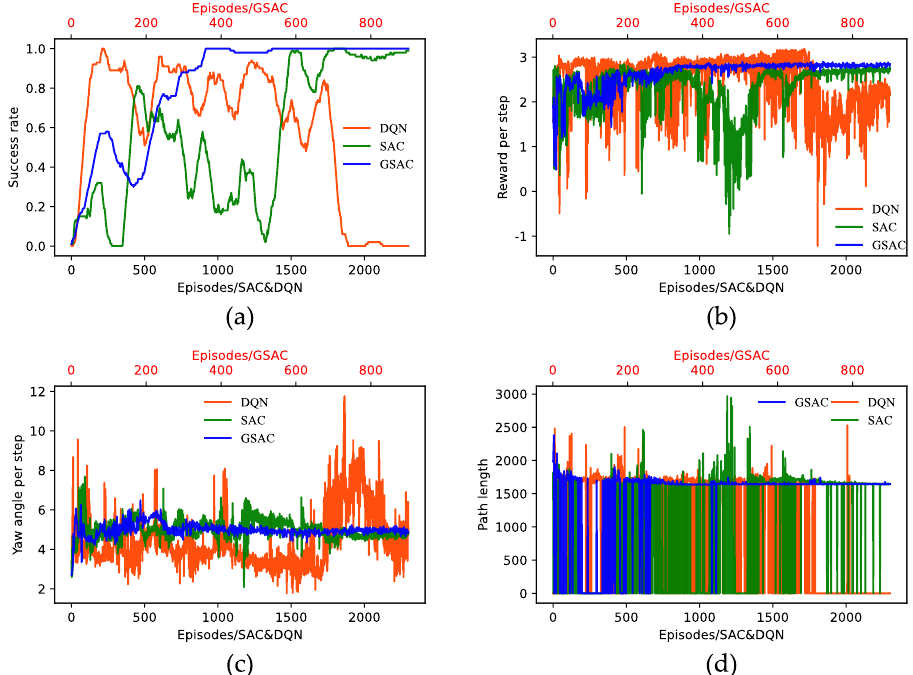
Figure 11. Dynamic environment simulation curves. ( a ) Success rate (last 100 episodes). ( b ) Reward per step. ( c ) Yaw angle. ( d ) Path